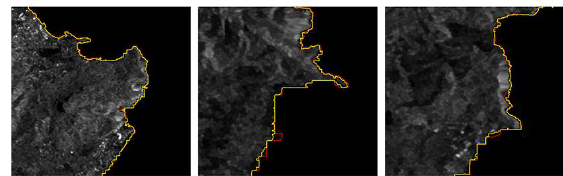
Figure 9. Extracted coastlines and manually digitized coastline details (yellow: SAR, red: manually created)